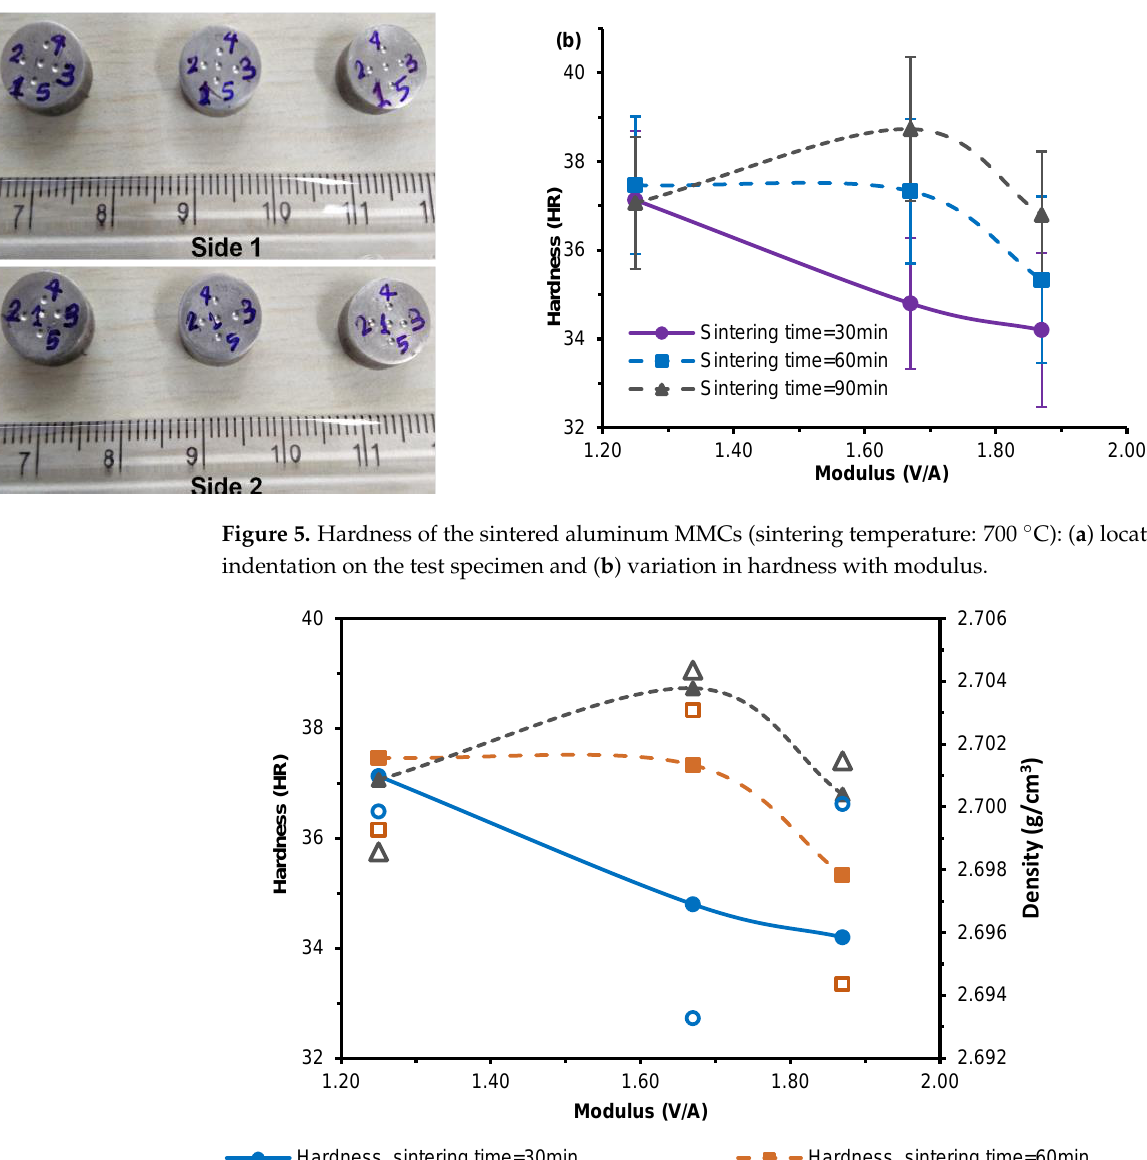
Figure 5. Hardness of the sintered aluminum MMCs (sintering temperature: 700 °C): ( a ) location of indentation on the test specimen and ( b ) variation in hardness with modulus.